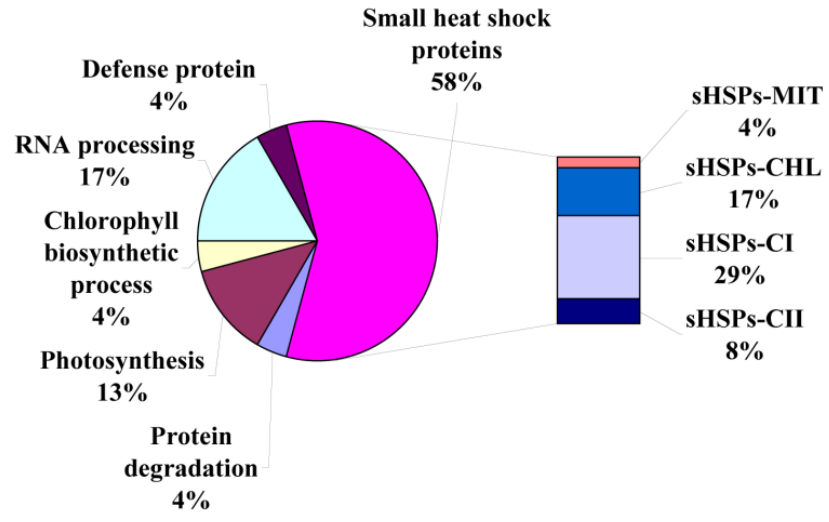
Figure 4. Functional groups of differentially expressed proteins identified in the control and heat-treated P. ternata leaves. This classification is based on their homologs and the literature. A total of six functional categories and their percentages are